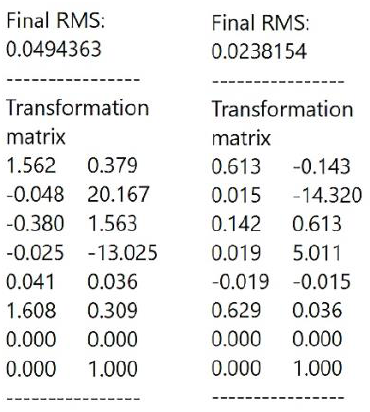
Table 2: RMS [m] value carry out comparing Super- Resolution images data set dense Cloud with the Ground Truth Source one, for façade (on the left side) and the portal (right side).